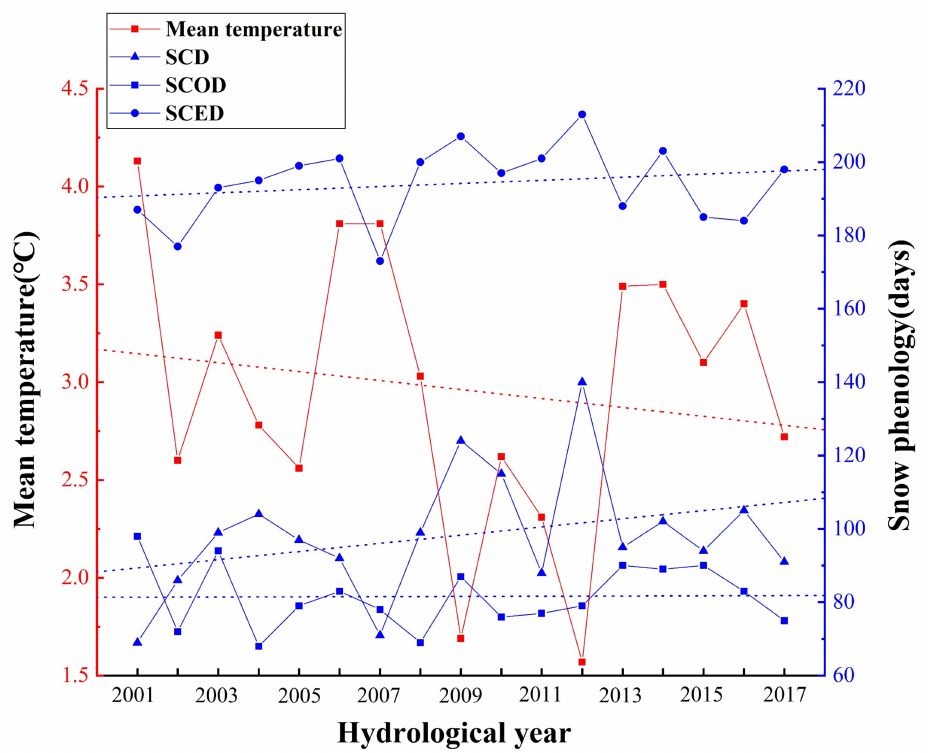
Figure 14. Annual variations in the mean temperature and snow phenology from HY2001 to HY2017.